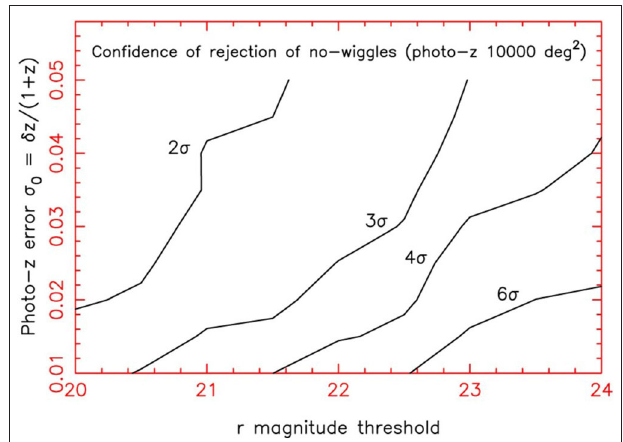
FIGURE 2 | Figure from Blake and Bridle (2005). Confidence boundaries of photometric redshift imaging surveys with variable photometric error thresholds. The probabilities are expressed as a rejection “ σ number” for a Gaussian distribution. A detection area of 10,000 deg 2 is